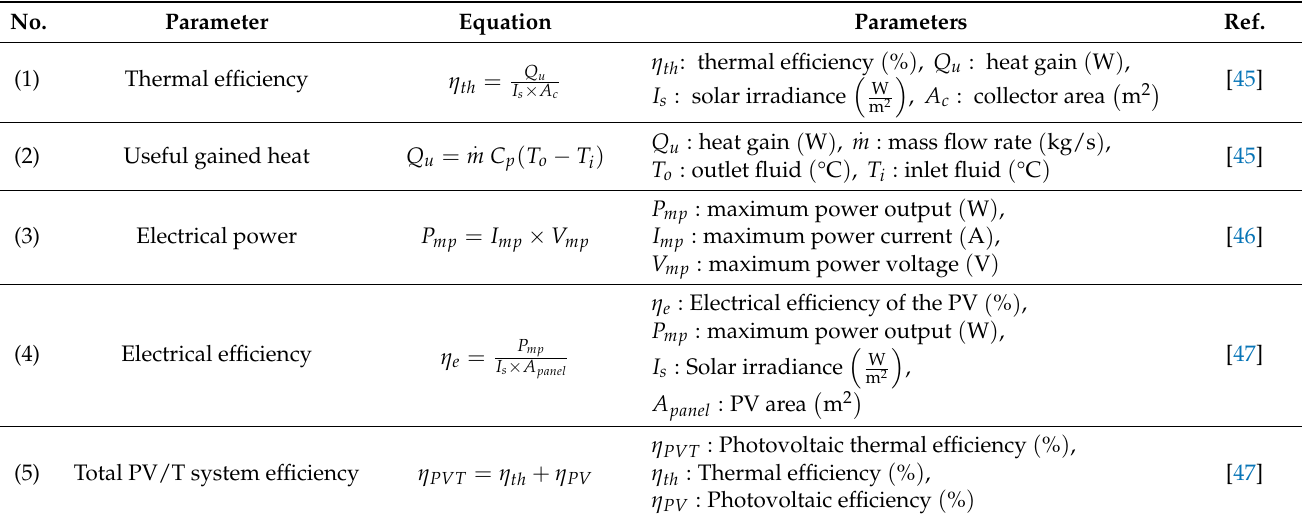
Table 5. Energy analysis